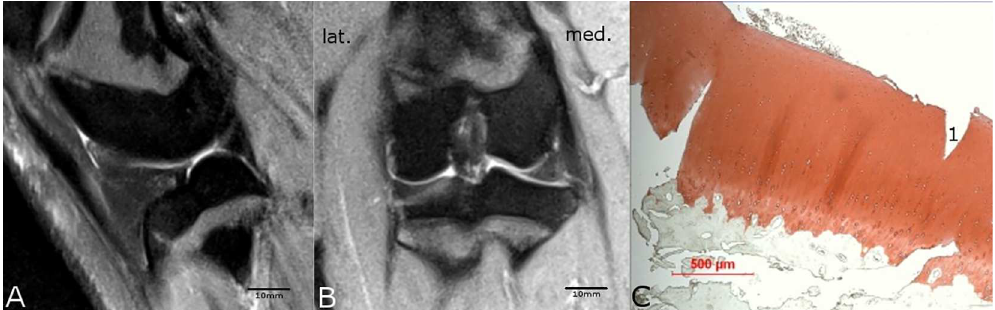
the kneenorin the coronalMRI-scan(B) andwas thereforeratedas unchanged.The scalebars for A andB were determinedwiththe programRadiAntDICOM viewer(see captionFig 1).In contrastto the MRI results, the histological safranin-ostaining(C) showeda moderate degeneration (Little-score: 10.5points)witha fissure (1) in the cartilageand detachment of the topmostlayerof the cartilagetissue.The histologicalfindingandthe MRI resultdidnot concur.